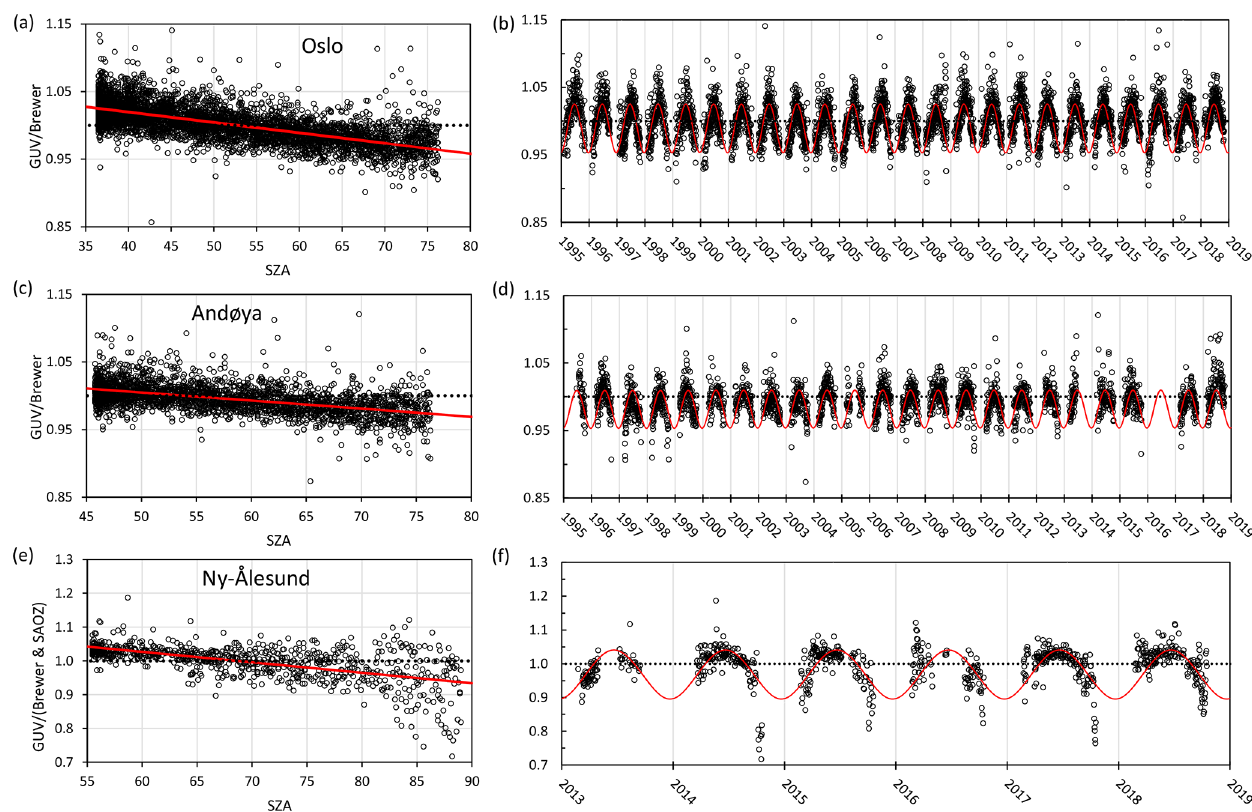
Figure 2. Ratios of GUV / Brewer(DS) ozone values measured in Oslo (a, b) , Tromsø/Andøya (c, d) , and in Ny-Ålesund (e, f) . SAOZ ozone data are also used in Ny-Ålesund. Panels (a) , (c) , and (e) show TOC ratios as a function of SZA, where the red lines represent the linear fit. Panels (b) , (d) , and (f) show daily TOC ratios for all years with simultaneous measurements. The statistical fit functions are marked as red